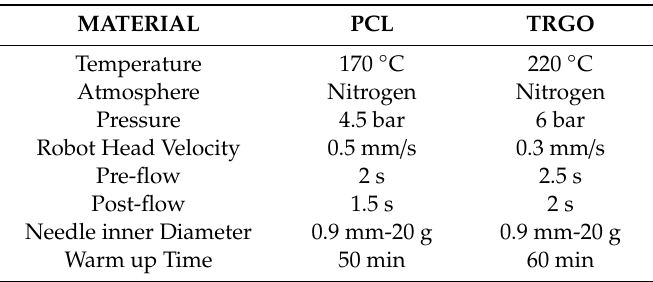
Table 1. Printing parameters for obtaining Polycaprolactone (PCL) and PCL / Thermally Reduced Graphene Oxide (TrGO) sca ff